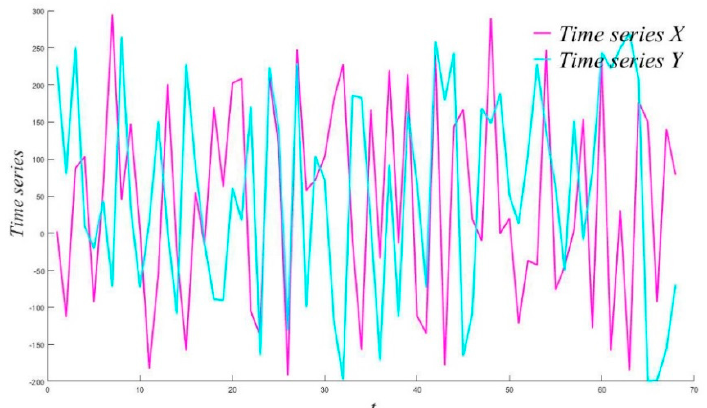
− 0.024 and 0.027, respectively).